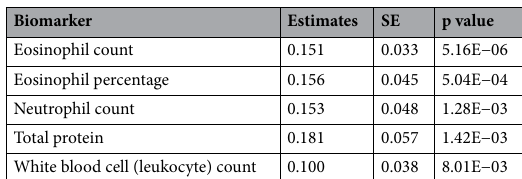
Table 3. Top 5 blood biomarkers with the smallest p value. Causal estimates, standard error, and p values of blood biomarkers in the MR-Egger regression.